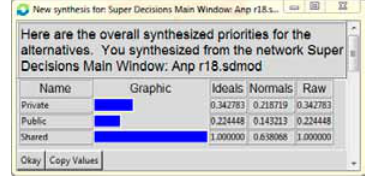
Fig. 4. Final results to allocated interest rate risk